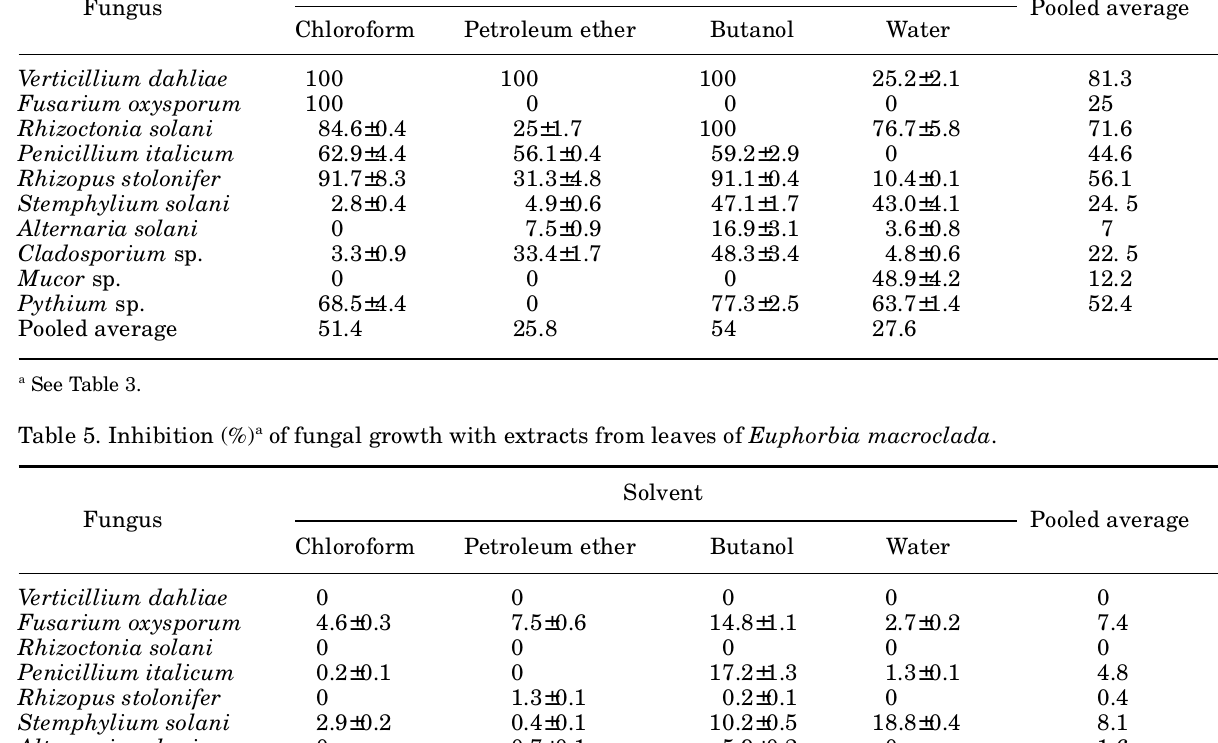
Table 4. Inhibition (%) a of fungal growth with extracts from stems of Euphorbia macroclada . Fungus